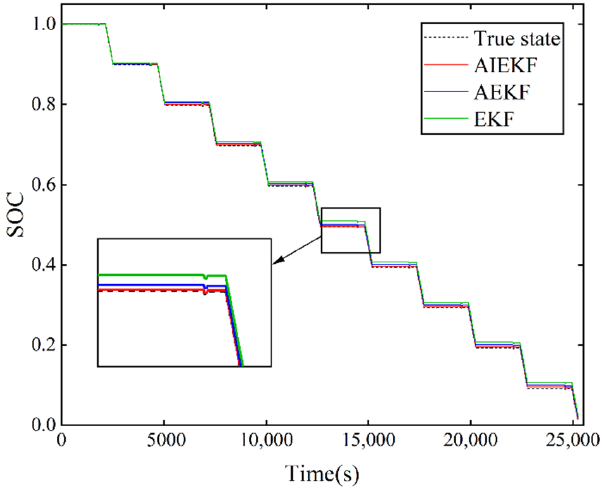
Figure 7. SOC estimation results of AIEKF, AEKF, and EKF under HPPC operating conditions.